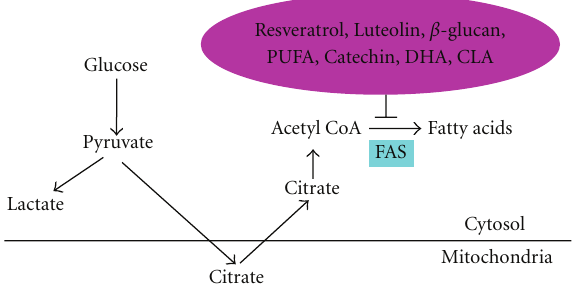
Figure 2: Fatty acid synthase as a metabonomic target for bioactive food components in cancer cells. Tumor cells exhibit the increased activity of FAS, which converts citrate-originated acetyl-CoA to fatty acids, mainly palmitate. The citrate is generated in mitochondria and, instead of further oxidation, is exported to cytosol as citrate. Upon exit, citrate forms acetyl CoA and is converted to fatty acids in cytosol, which is suppressed by a variety of dietary components, including tea catechin, DHA in fish oil, β -glucan in barley and mushrooms, resveratrol in red grapes, the vegetable flavonoid luteolin, and CLA in milk. FAS: fatty acid synthase; CoA: coenzyme A; PUFA: polyunsaturated fatty acid; DHA: docosahexaenoic acid; CLA: conjugated linoleic